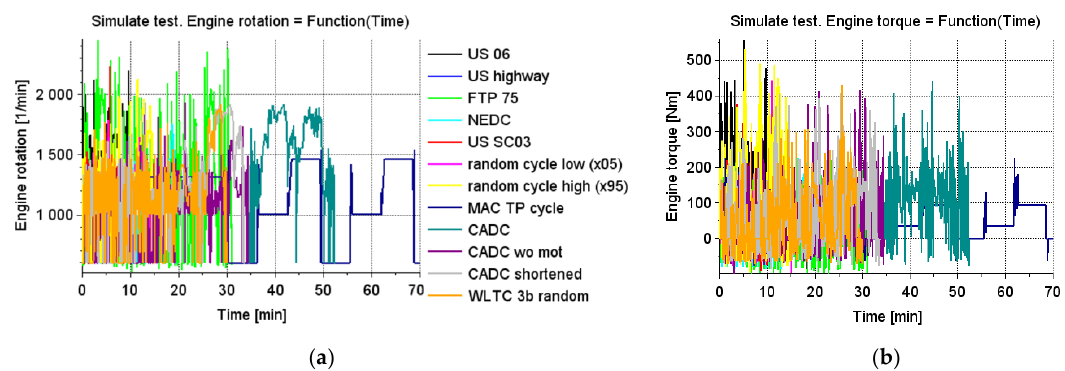
Figure 8. Results obtained in the simulation of selected road tests for the 2013 Mercedes E350 vehicle: ( a ) Waveforms of the instantaneous values of the vehicle engine rotational speed; ( b ) Waveforms of the instantaneous values of the torque generated by the vehicle engine.